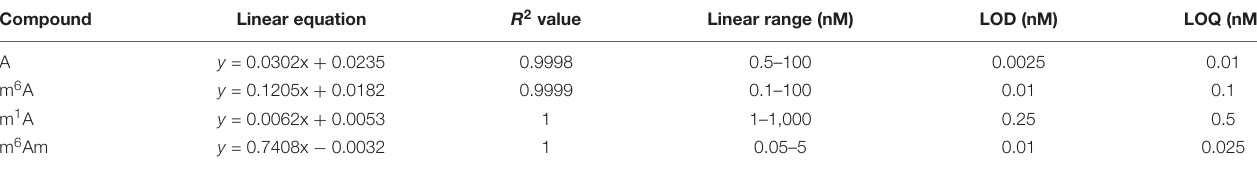
TABLE 2 | Linearities of A, m 6 A, m 1 A, and m 6 Am in the HILIC-MS/MS analysis method.